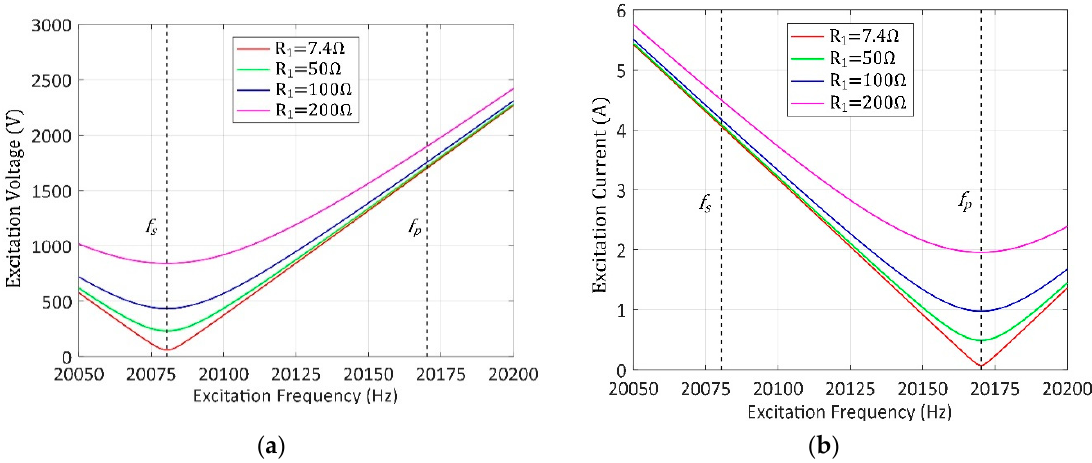
Figure 2. Variations in excitation voltage ( a ) and current ( b ) under the same vibration amplitude.